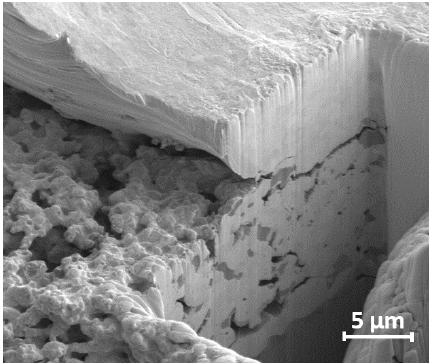
Figure 13. The focused ion beam (FIB) cut through the centre of a wire bond on thin film platinum metallisation.